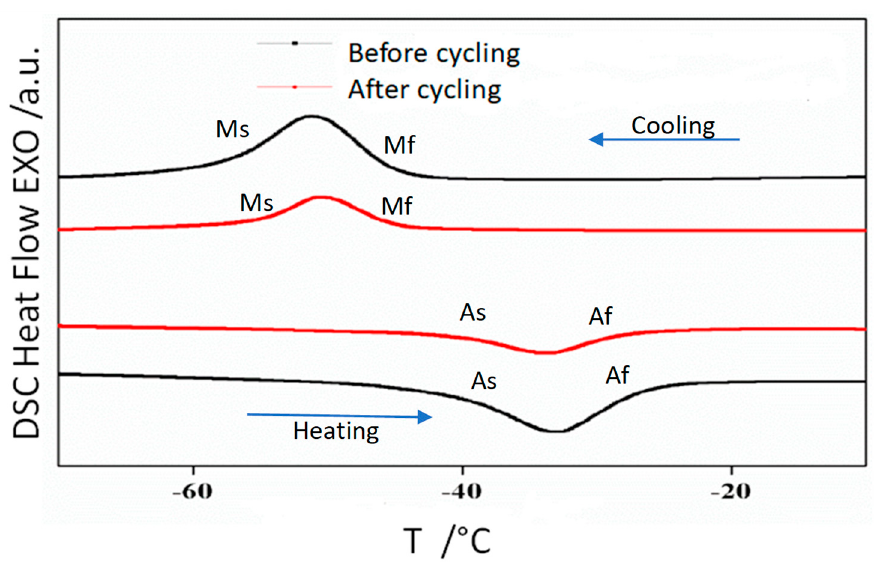
Figure 4. DSC reversible scans of alloy Ni 48 Mn 36 Sn 14 Cu 2 before and after 100 thermal cycles. Table 2. Equilibrium Gibbs temperature, T o , and thermodynamic parameters (enthalpy ∆ H, entropy, ∆ S) of the structural transformation before and after thermal cycling (before values are calculated following the procedure and data provided in reference [21]). T o is one half of M s + A f .